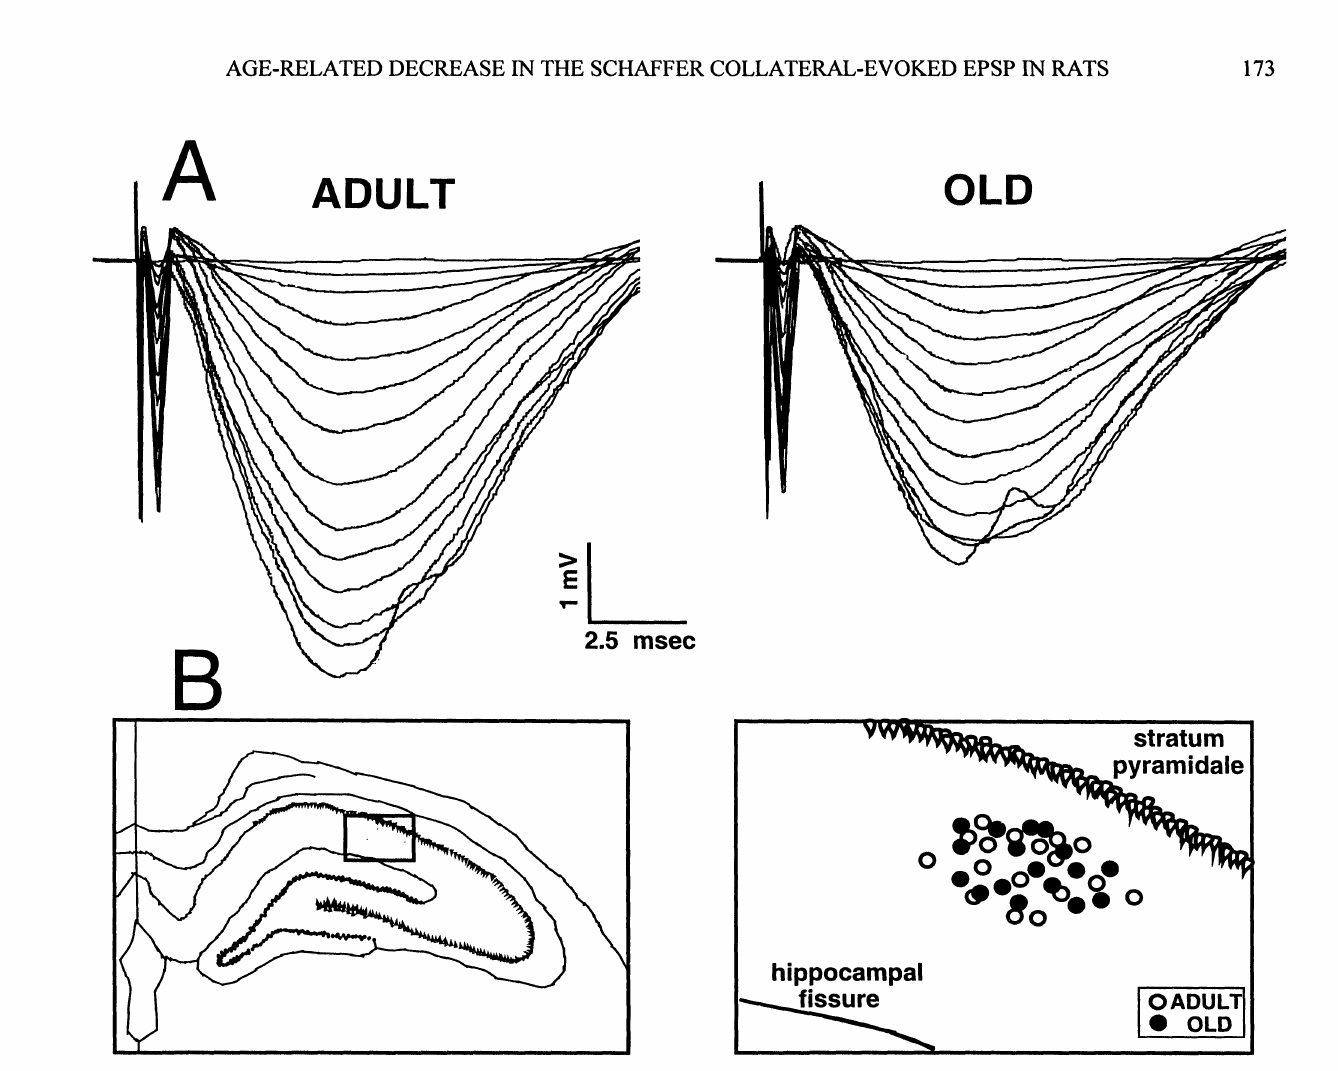
Fig. 3: A. Example of Schaffer collateral-CA1 pyramidal cell responses in one young and one old rat, collected at 14 different stimulus intensities. Each trace is an average of five individual evoked responses. B. Schematic diagram indicating the approximate locations of the recording sites at which the input-output series was conducted in CA stratum radiatum (O, adult;